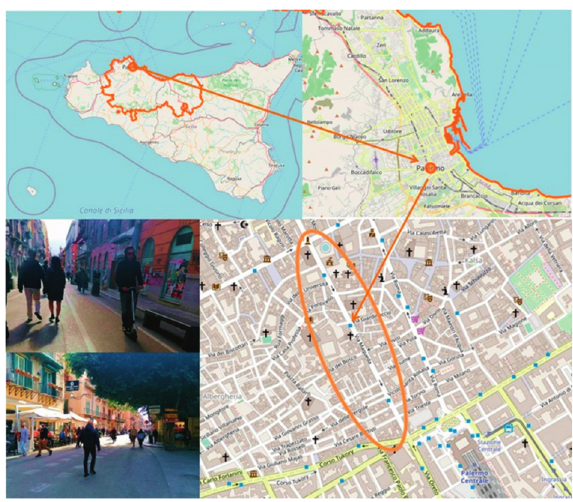
Figure 1: Case study area: Via Maqueda, Palermo, Italy (Source: Google